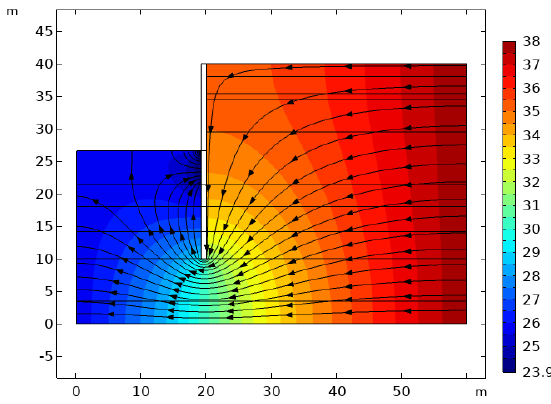
Figure 7. Flow network diagram with waterproof curtain.